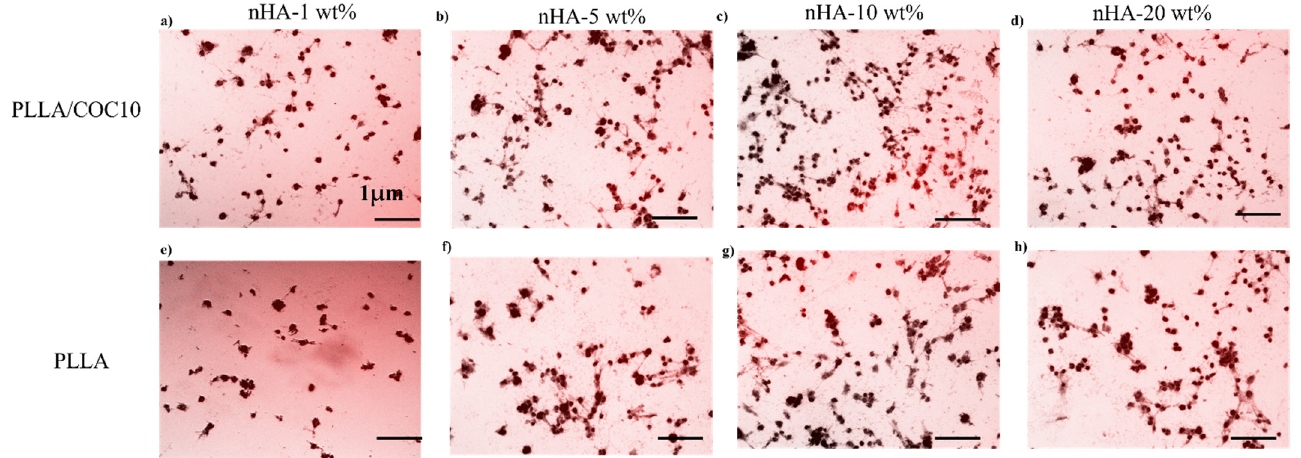
Figure 12. Alizarin red S staining was used to analyze the mineralization of MC3T3-E1 cells for PLLA/COC10-nHA ( a – d ) and for PLLA-nHA ( e–f ). MC3T3-E1 cells were grown for 14 days, then stained with alizarin red S to identify mineralized nodules after 14 days. Scale bar: 1 μ m in all the images. Nanocomposites had nHA in 1 wt%, 5 wt%, 10 wt%, and 20 wt%. After three different experiments, the data is represented.